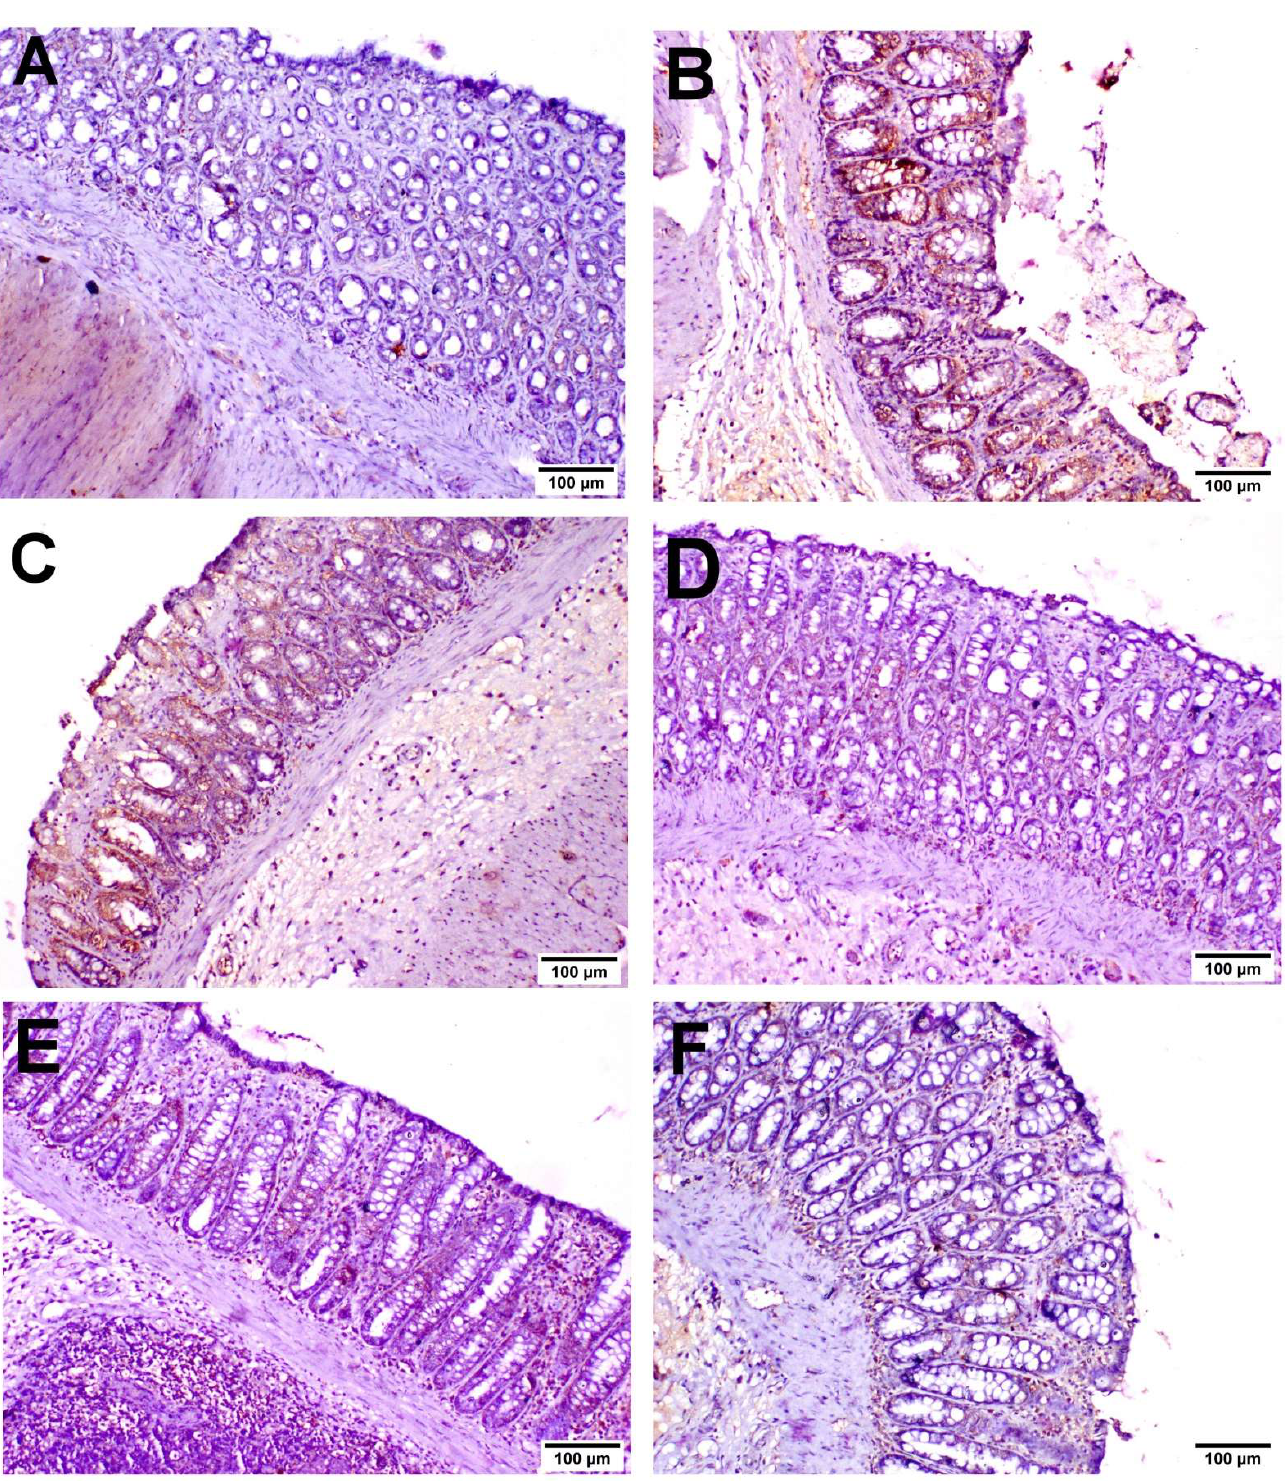
Figure 7. Immunohistochemistry of Caspase-3 expression in the colon of the different groups: ( A ) NC group; ( B ) UC group; ( C ) MIC-20 group; ( D ) MIC-40 group; ( E ) SSZ-100 group; ( F ) MIC + SSZ group.